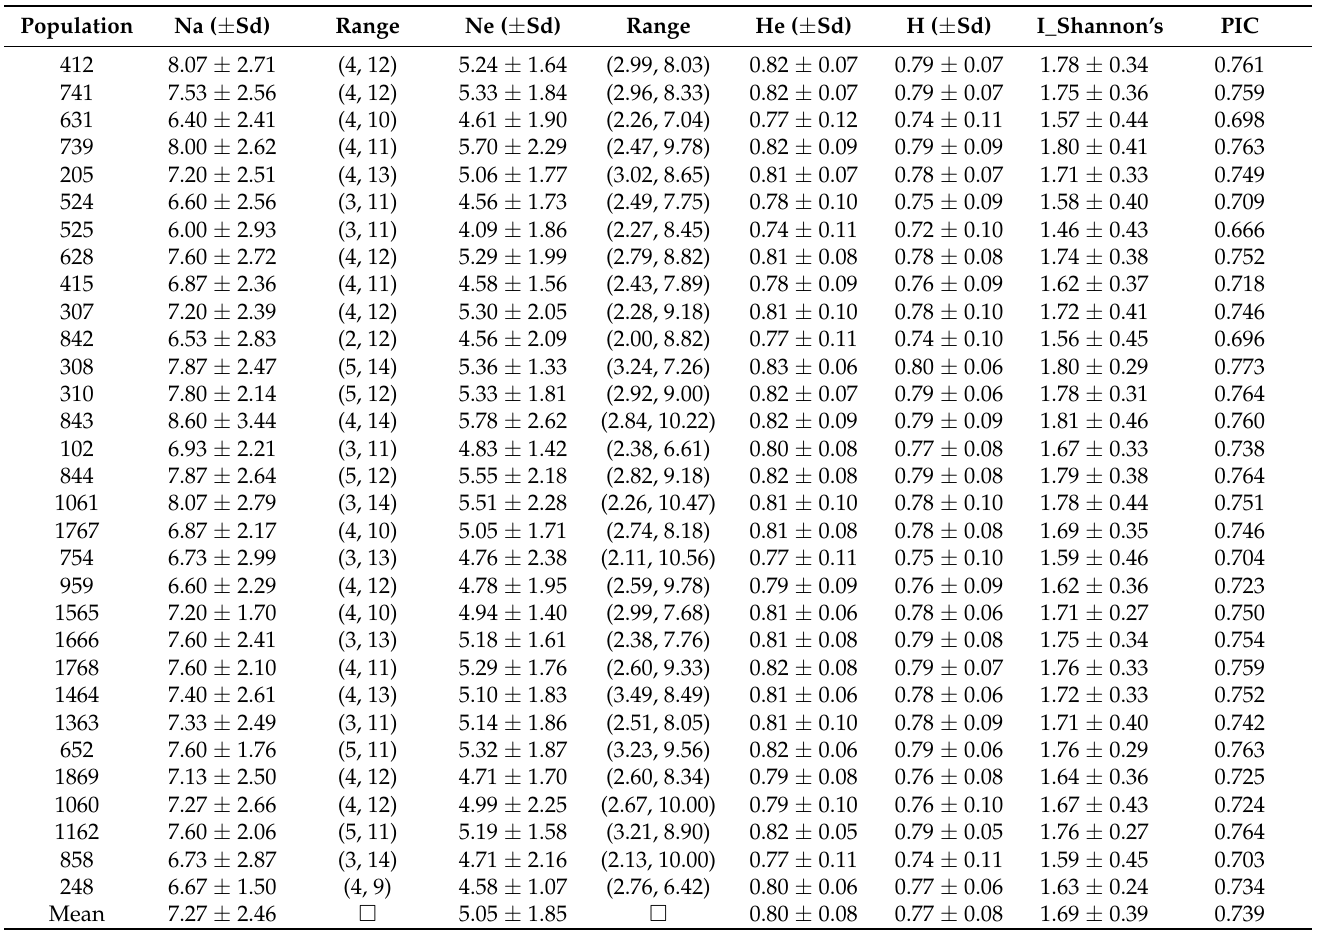
Table 2. Number of alleles, polymorphic information content (PIC), expected heterozygosity (He), gene diversity (h), and Shannon’s information index ( I ) for 31 populations of M. azedarach